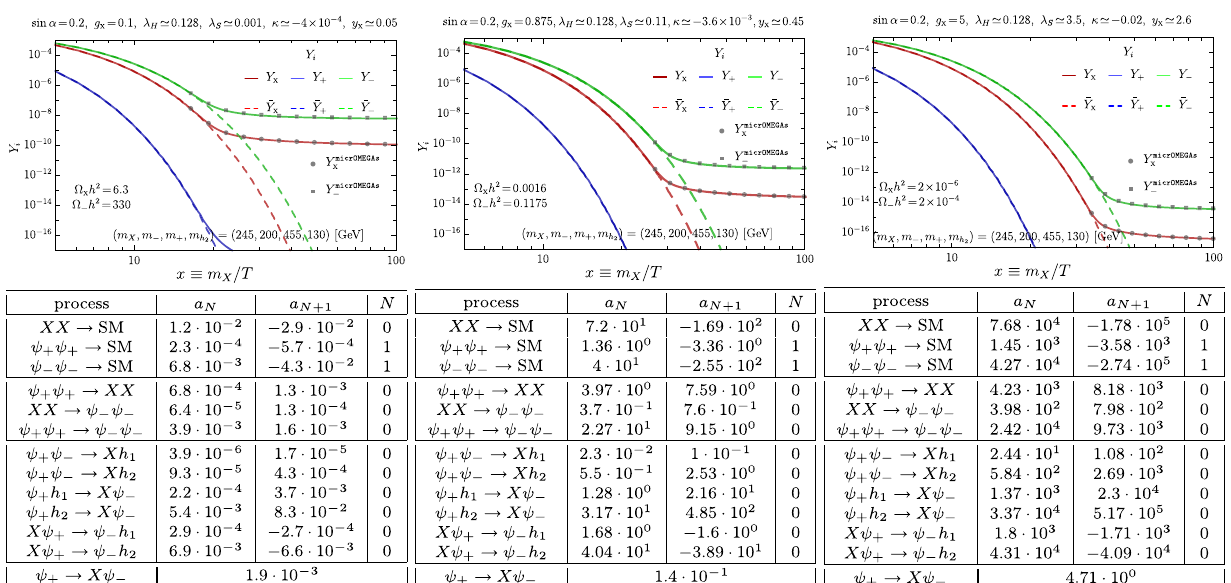
micrOMEGAs code. The left, middle and right plots are for the values of parameter g x = 0 . 02 , 0 . 2 and 1, respectively. The values of other model parameters are shown in the legends of plots and the relic den- sity of two dark matter particles Ω X , − h 2 is also given in each plot. The tables contain first two non-vanishing coefficients of thermally- averaged cross-sections (pb) expanded in powers of x − 1 , given by − N + a − ( N + 1 ) + ··· , and the decay width (cid:8) σ ijkl v (cid:9) = a N x N + 1 x M ∅ l (cid:8) Γ ψ (cid:9) + → X ψ −